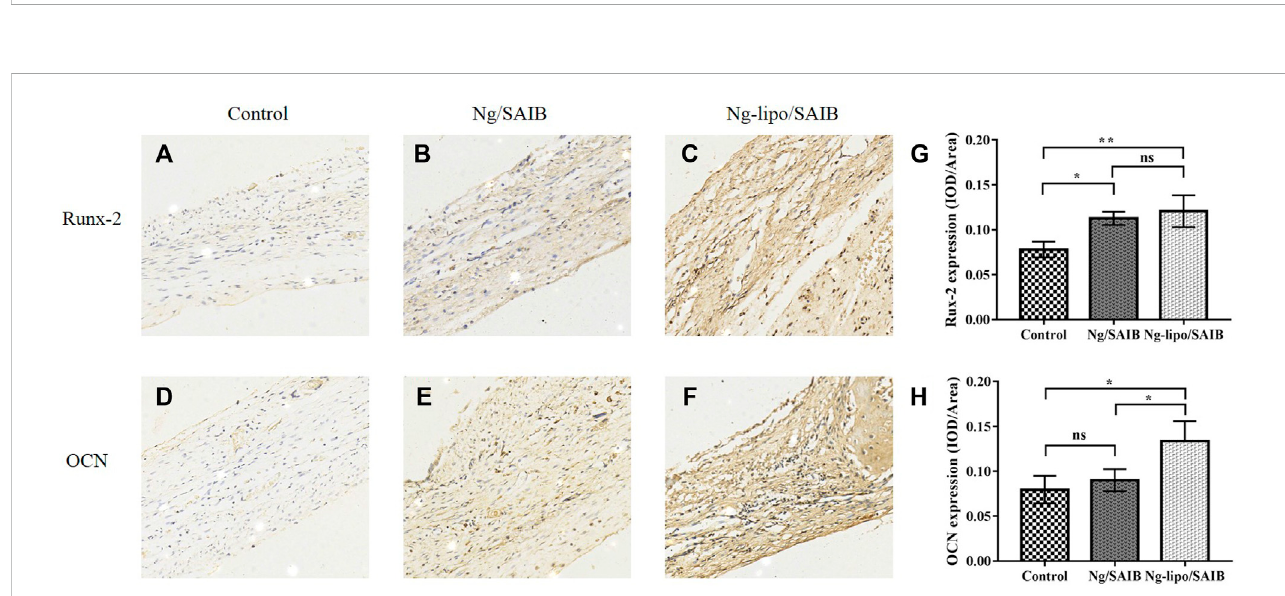
FIGURE 8 Representative immunohistochemical staining of the osteogenic marker Runx-2 after 2 weeks (A – C) and osteogenic marker OCN after 8 weeks (D – F) . The corresponding quantitative comparison of osteogenic expression of Runx-2 after 2 weeks (G) and OCN after 8 weeks (H) (* p < .05, ** p < .005, ns, no signi fi cance). Scale bar, 20 μ